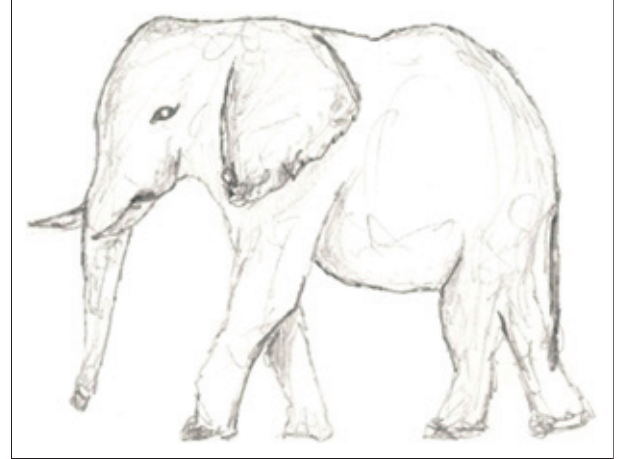
FIGURE 4: Illustration from Nadine’s digital